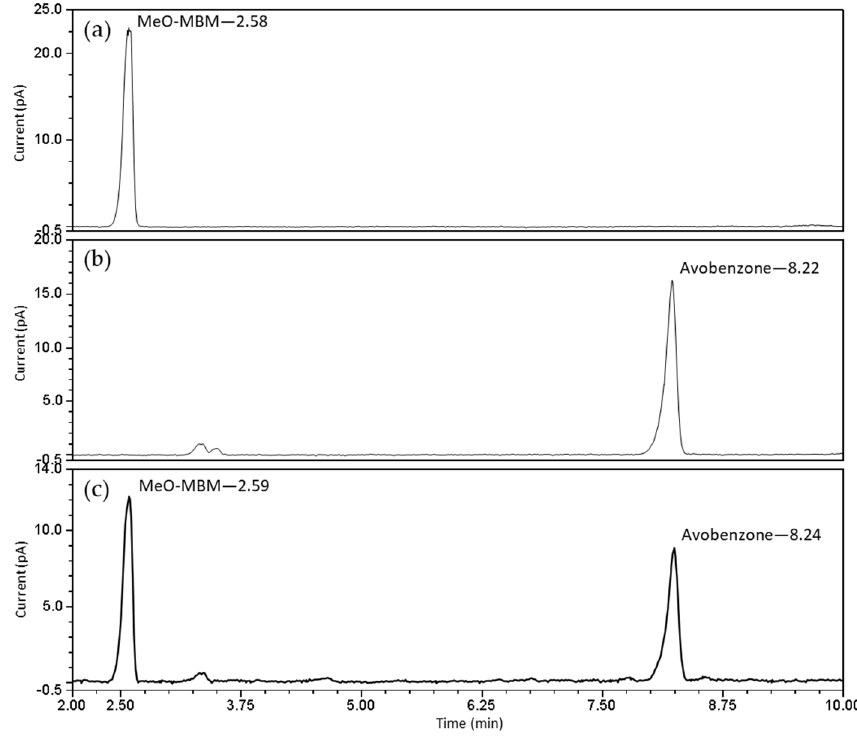
Figure 4. UHPLC-CAD chromatograms of MeO-MBM ( a ) before irradiation, ( b ) avobenzone, and ( c ) MeO-MBM after irradiation at 250 kJ/m 2 in